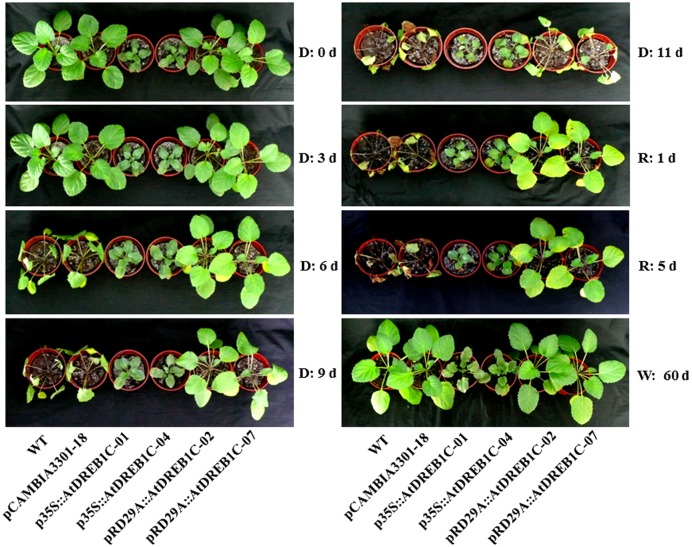
Morphological changes in wild-type and transgenic plants under drought stress. D, drought; R, re-watered; W, well-watered; WT, wild type. The transgenic lines are indicated by the construct names followed by the line number: p35S::AtDREB1C-01 refers to p35S::AtDREB1C line 01 and so on; pCAMBIA3301-18 was used for the positive control.